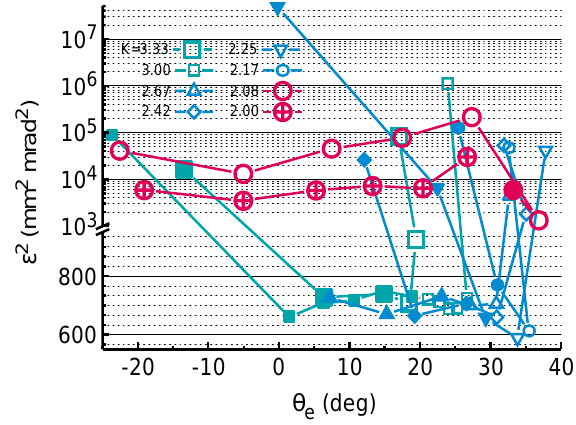
FIG. 7. (Color) Dependence of square emittance on the exit point. For K (cid:1) 2 and 2.08, the radius of the loop after the foil is large and defocusing along sector edges cannot be avoided. Cor- responding square emittances are 2 orders of magnitude larger than those of beams with larger K . For K $ 2.17 , the width of the region where ´ 2 is small increases with K , as expected. Values of square emittance between sudden increases are of the order of 700 mm 2 mrad 2 and do not depend much on the extrac- tion point nor the K parameter. Sudden increases of the order of magnitude of square emittance correspond to negative influences of the magnetic field gradients. The upper u e limits of low ´ 2 segments are set by the sector edge B (Figs. 4 and 5). The lower u e limits of low ´ 2 segments for 2.17 # K # 2.67 and K $ 3 are set by sector edges A and C, respectively (Figs. 4 and 5). Solid symbols on data points depict less favorable foil positions placed over a sector, while open symbols correspond to foil po- sitions in the valley. For another cyclotron, the curve parameter K should be replaced with K (cid:1) V , where V is the angular width of the valley. Consequently, for a broader valley, e.g., a three sector per pole cyclotron, the problem of large emittance of the beams with K # 2.08 may disappear. The square emittance of negative ion beams is not shown because it is practically inde- pendent of u e and is smaller than the square emittance of positive ion